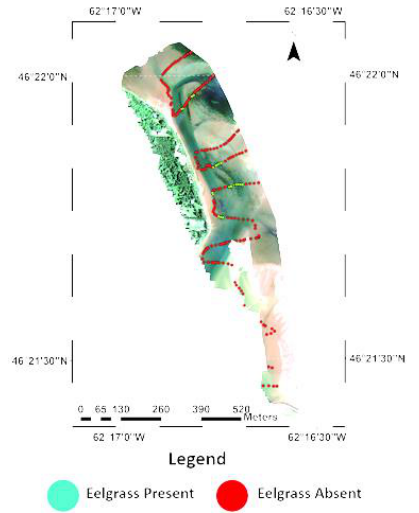
Figure 8. Distribution of the sonar points over the UAV image